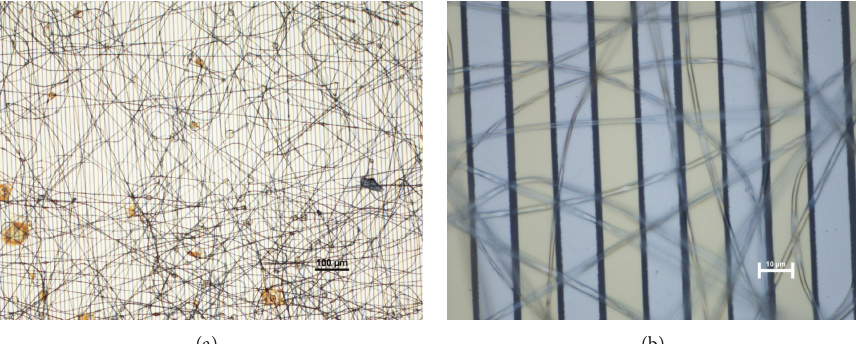
Figure 3: Optical microscope image of the collected coaxial nanofibers on coplanar bimetallic interdigitated electrode substrate at 10x (a) and 100x